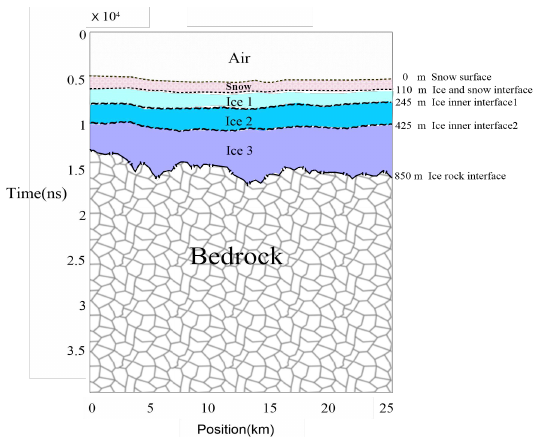
Figure 7. Internal layer from the airborne ice-penetrating